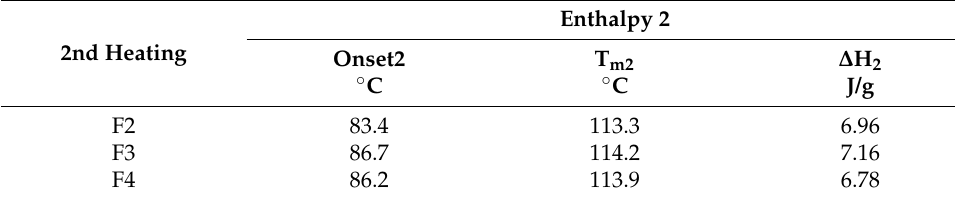
Table 5. Melting of studied primary compounds.